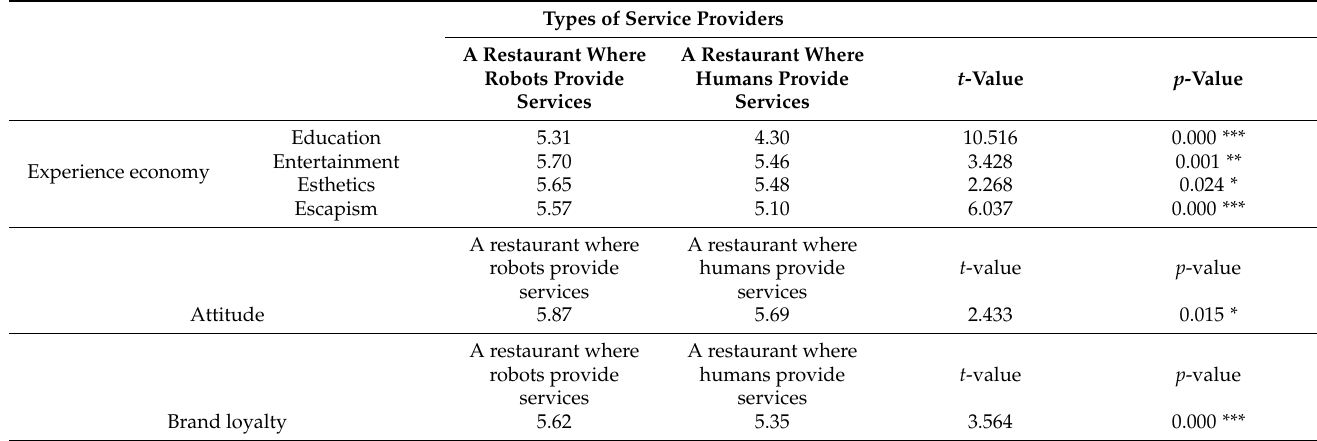
Table 4. Results of t -tests: Effects of types of service providers on experience economy, brand attitude, and brand